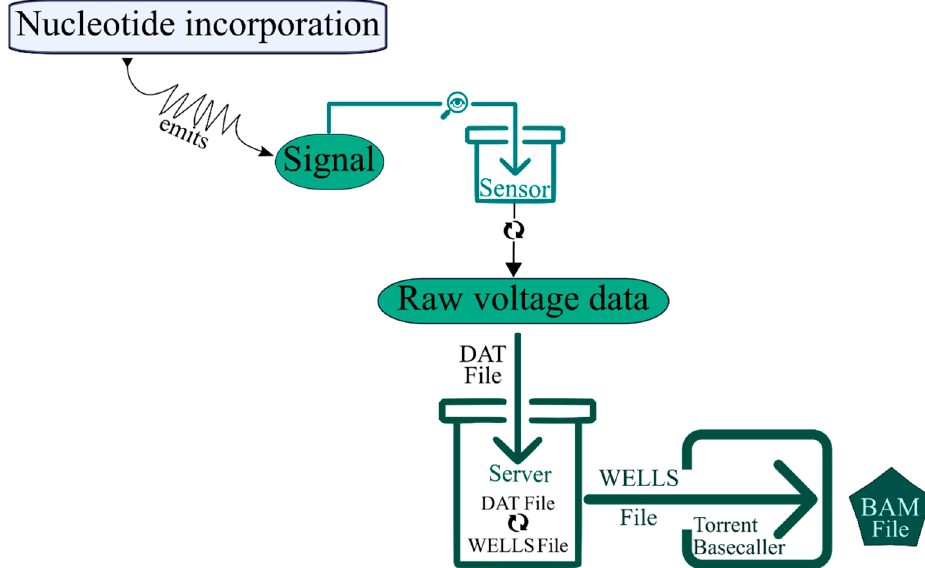
Figure 3. Schematic representation of the primary analysis workflow in Ion Torrent. Briefly, the signal emitted from nucleotide incorporation is inspected by the sensor, which converts the raw voltage data into a DAT file. This file serves as input to the server, which converts into a WELLS file. This last file is used as input on the Ion Torrent Basecaller module that gives a final BAM file, ready for the secondary